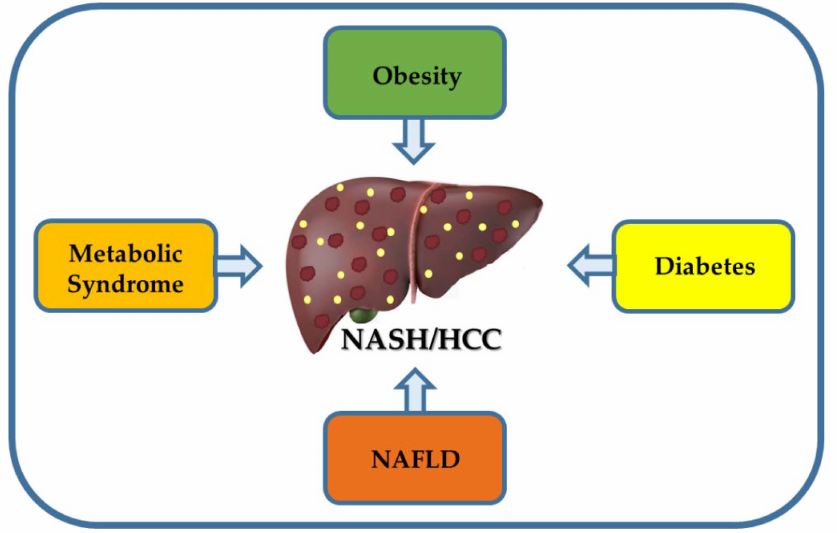
Figure 1. Main risk factors for NASH and HCC development. Obesity is associated with the develop- ment of metabolic syndrome, diabetes, NAFLD, NASH, and HCC, which may act synergistically to accelerate the onset and development of NASH-derived